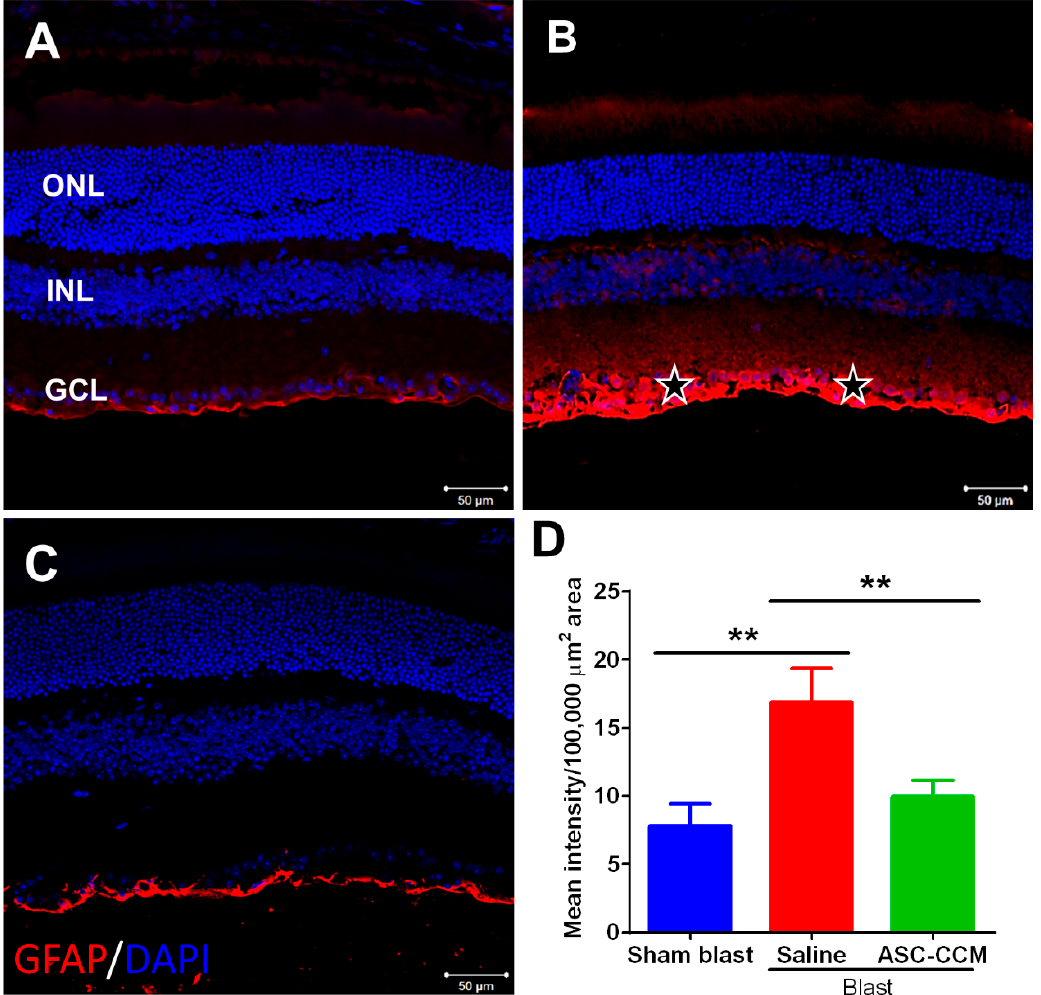
Figure 5. ASC-CCM reduces retinal glial fibrillary acidic protein (GFAP) expression in blast injury mice. ( A ) Normal GFAP immunoreactivity is present in the sham group retina. ( B ) Thirty days after blast exposure, GFAP immunolabeling (red) increases in the nerve fiber layer (NFL, stars) and inner retina. ( C ) Decreased GFAP expression in NFL and inner retina in blast mice with ASC-CCM compared to blast mice with saline. ( D ) Image J quantification of GFAP intensity. Data represent Mean ± SEM from n = 6–7 animals/group. **, p < 0.01. Scale bar = 50 μ m.